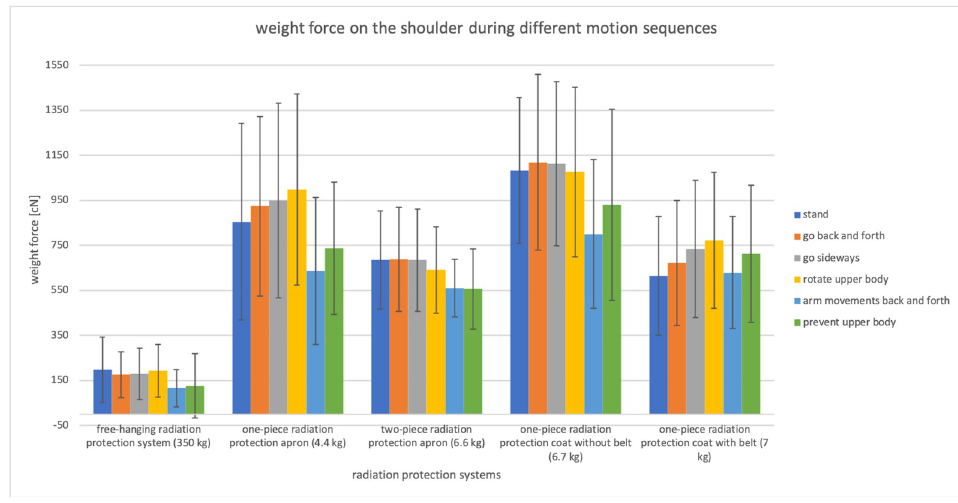
Fig 4. Shoulder loads and their standard deviation during different movements when wearing different radiation protection aprons are shown. The free-hanging radiation protection system showed a significant (p < 0.05) difference in the weight on the shoulder while rotating upper body and with arm movement back and forth. For the one-piece radiation protection apron without belt, a significant (p < 0.05) weight reduction on the shoulder was measured when the arms were in moving position (moving sequence 5), in contrast to the other moving positions